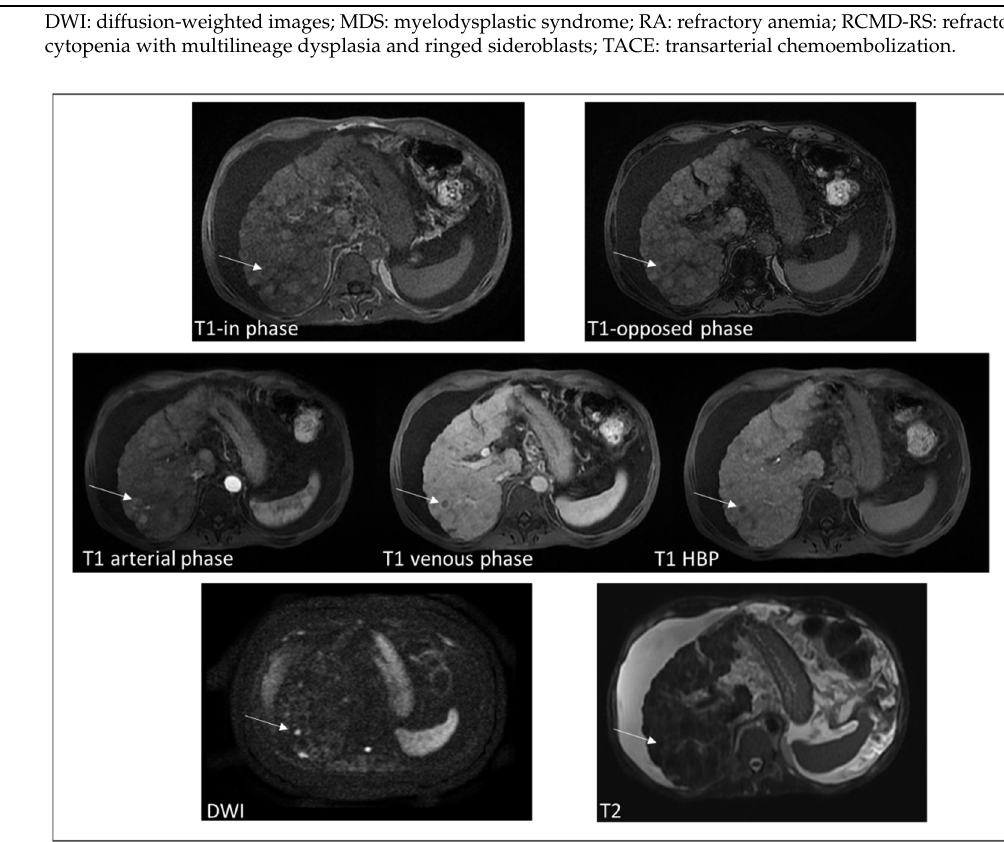
Figure 1. MRI images of a 55-year-old man affected by secondary hemocromatosis and HBV cirrhosis, with a nodular lesion in the VIs. The T1-in phase image (TE = 4.8 ms) did not show liver parenchyma hypointensity in comparison to T1. opposed phase image (TE = 2.4 ms) as the liver iron concentration was mild. However, in the T2 weighted image we can qualitatively appreciate a diffuse hypointensity of liver parenchyma. The lesion appeared faintly hyperintense on T2-w image, showed hypervascularization in arterial phase and wash-out in venous phase. It was hypointense in the hepatobiliary (HBP) phase and had signal diffusion restriction on diffuse weighted images (DWI). The lesion turned out to be